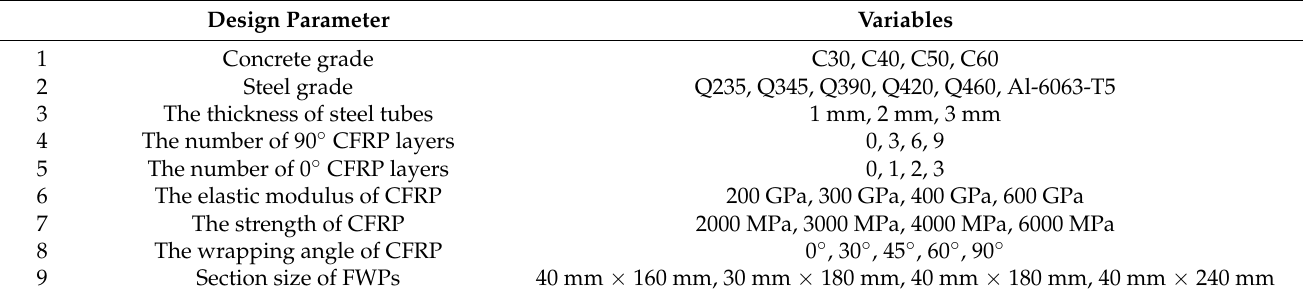
Table 9. Design parameter variables.